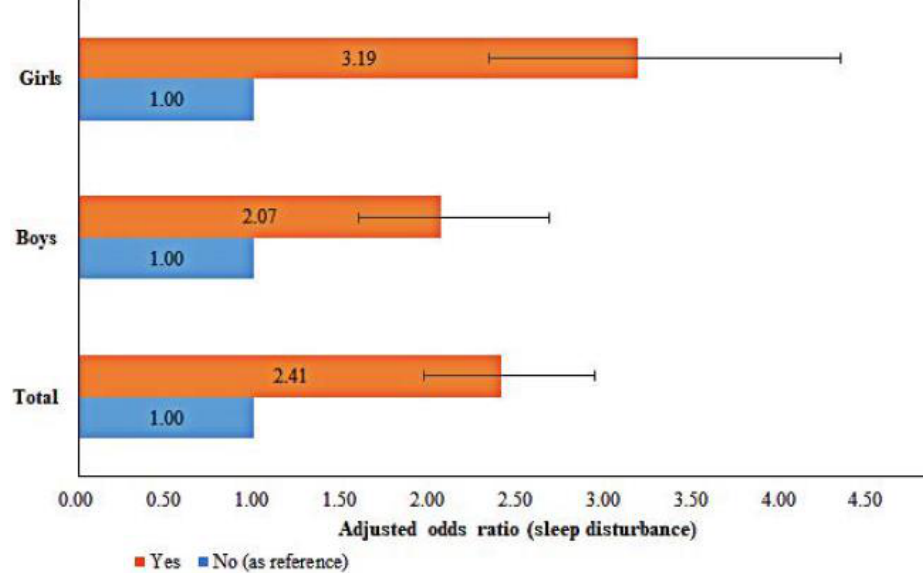
Figure 1. Adjusted association between problematic Internet use (PIU) and sleep disturbance: stratified by sex.